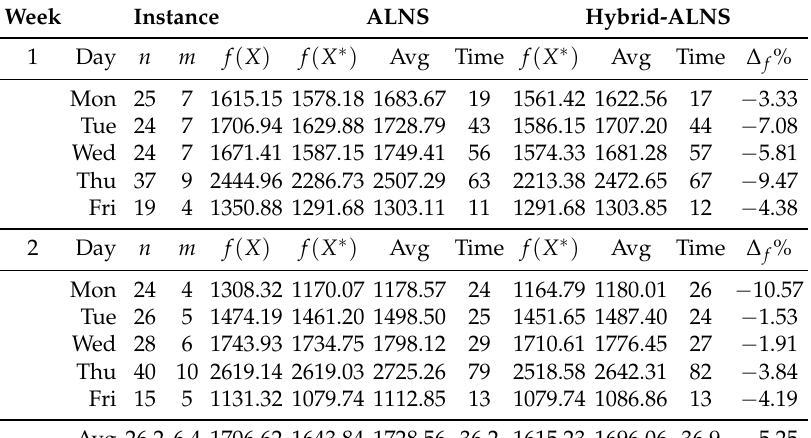
Table 1. Results on real-life instances.